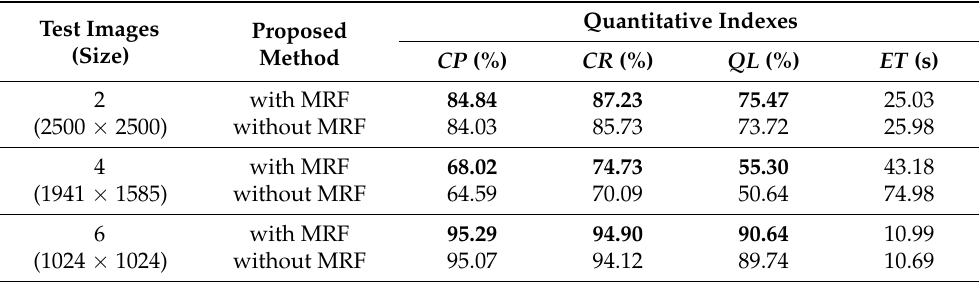
Table 6. Quantitative indexes of centerline extraction in test images 2, 4, and 6, using the proposed method with and without the MRF procedure.